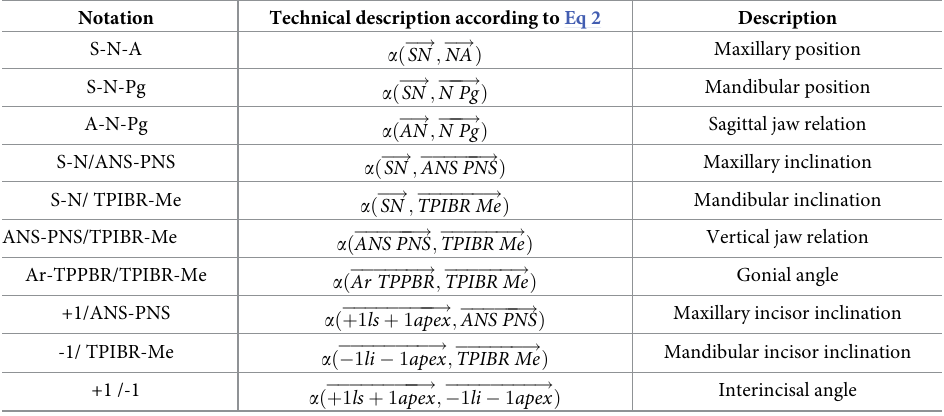
Table 3. Description of the angular measurements of the cephalometric